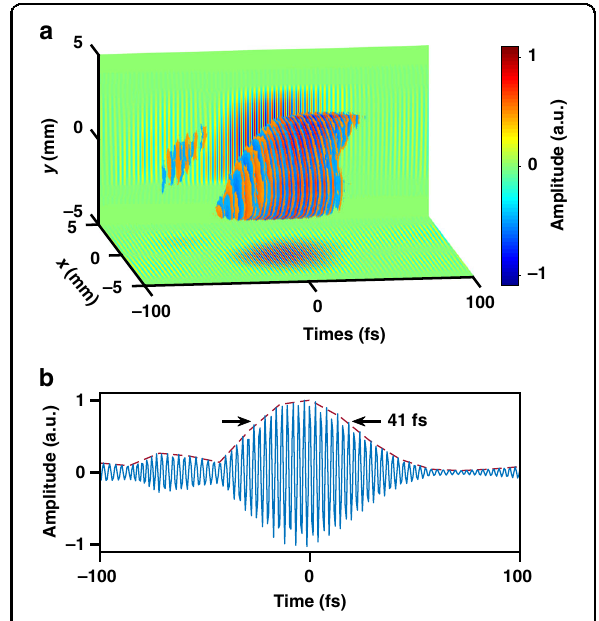
Fig. 5 3D topographic maps of femtosecond laser pulses measured by COFT based on 3D spectral holography. a Spatiotemporal distribution of the electric fi eld of a femtosecond laser pulse from the same laser system as Fig. 2. To clearly show the peaks and valleys of the optical fi elds, only regions where the absolute amplitude is higher than 0.4 times the peak absolute amplitude are shown. b Temporal pro fi le of the electric fi eld (blue lines) at the central point x ; y ð Þ ¼ 0 ; 0 ð Þ of the laser pulse in a , and the red